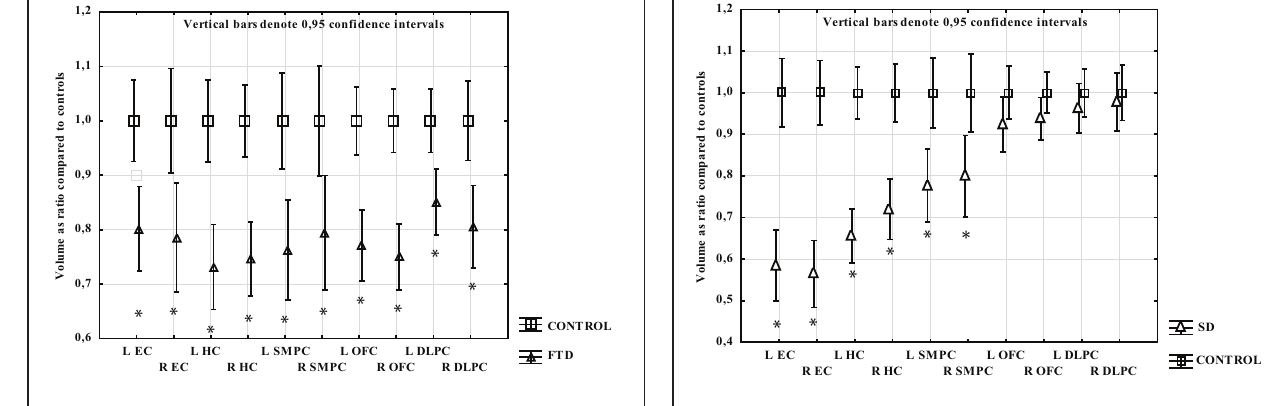
FIGURE 2 | The volume of measured region in FTD expressed as a ratio of CTL volume. CTL volume is set to 1. X-axis denotes the included regions: EC, entorhinal cortex; HC, hippocampus; OFC, orbitofrontal cortex; SMPC, subcallosal medial prefrontal cortex; DLPFC, dorsolateral prefrontal cortex. ∗ p < 0 . 01.